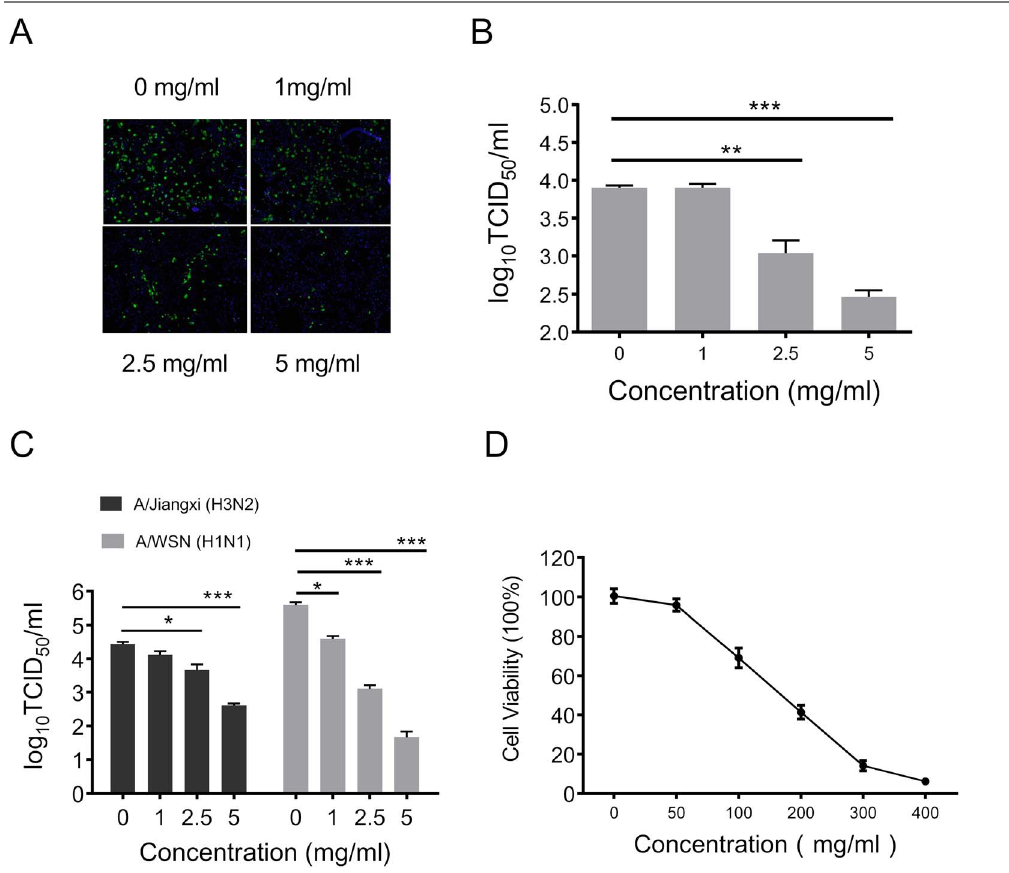
Figure 1. Cryptoporus volvatus extract inhibits influenza virus infection in vitro . (A and B) The Cryptoporus volvatus extract represses H1N1/BJ09 replication in MDCK cells. MDCK cells were infected with H1N1/BJ09 at an MOI of 0.1, and then treated with the Cryptoporus volvatus extract at various concentrations or the control normal saline. At 24 h p.i., cells were fixed and analyzed by IFA using antibody against virus NP protein (A), and virus yield in the supernatants was also quantified (B). Cultures treated with normal saline were set up as control (0 mg/ml). (C) Cryptoporus volvatus extract potently inhibits both A/Jiangxi (H3N2) and A/WSN (H1N1) replication in MDCK cells. A similar virus inhibition assay was performed with MDCK cells infected with A/ Jiangxi (H3N2) or A/WSN (H1N1) at an MOI of 0.1 in the presence of the Cryptoporus volvatus extract at various concentrations or the control normal saline. (D) Determination of cytotoxicity of the Cryptoporus volvatus extract by MTT assay. MDCK cells were incubated with various concentrations of the Cryptoporus volvatus extract or the control normal saline for 48 h prior to the MTTassay. Data are representative of three independent experiments (mean ¡ SEM). Statistical significance was analyzed by One-way ANOVA. * P , 0.05 ; ** P , 0.01 .